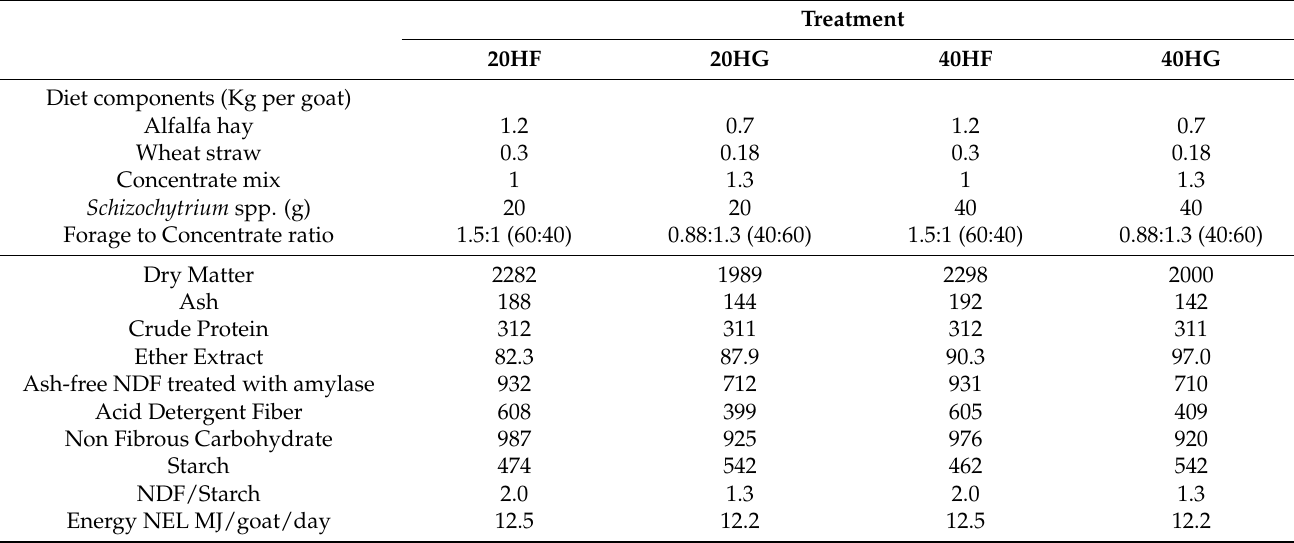
Table 2. Alfalfa hay, wheat straw and concentrates fatty acid profile (FA) (% of total FA).